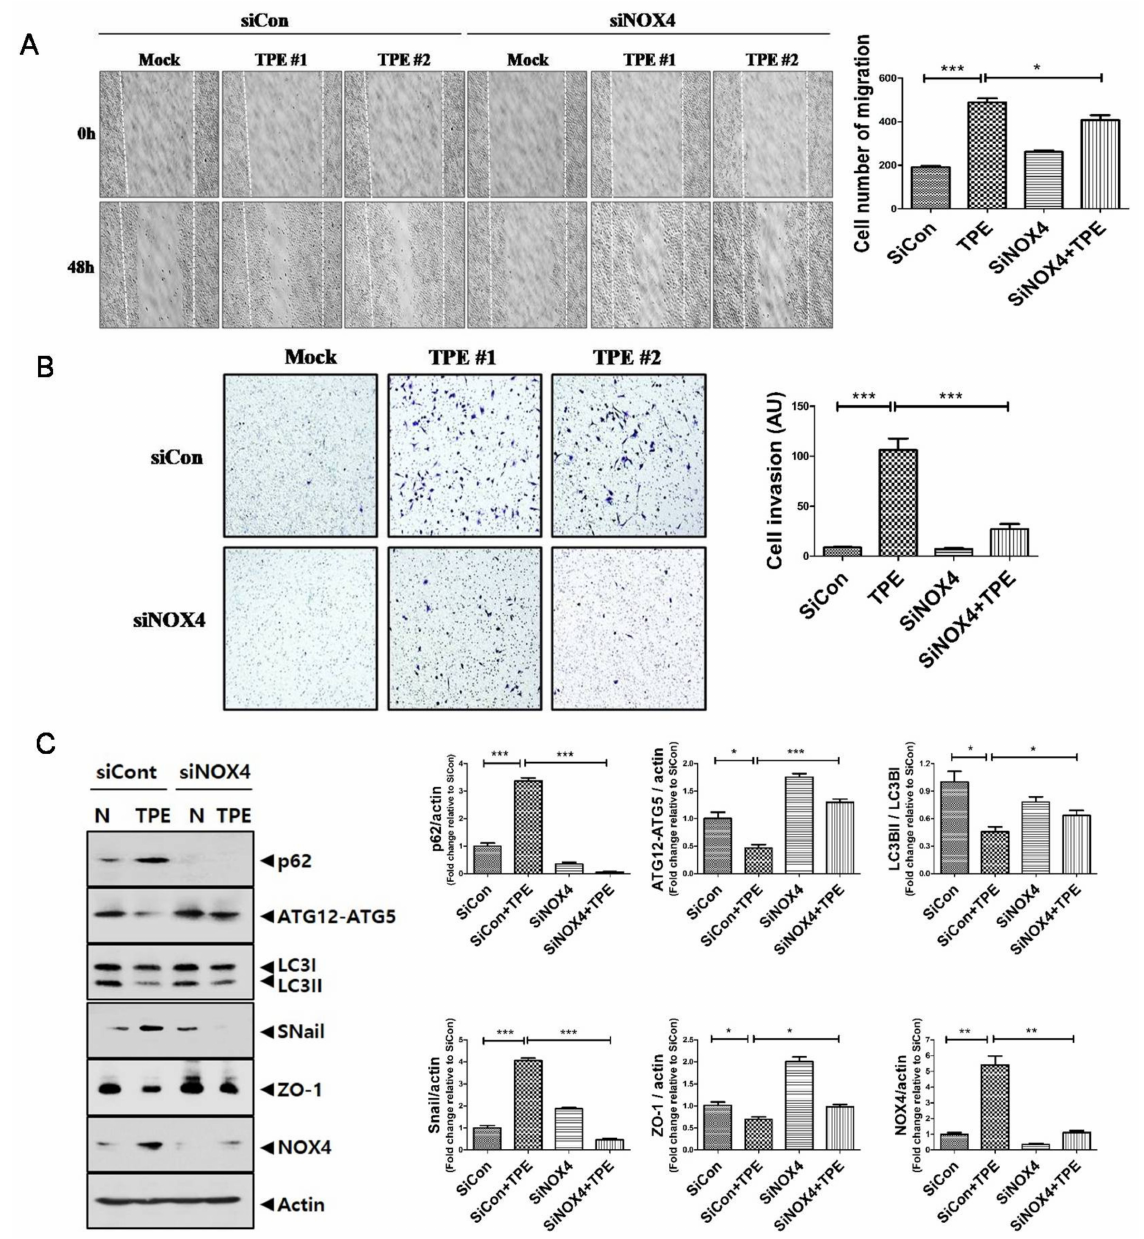
Figure 5. Tuberculous effusion enhances migration and invasion of lung cancer cell: Scratch-wound healing assay ( A ) and Transwell assay ( B ) showed thatNOX4 downregulation significantly prevented the migration and invasion of lung adeno- carcinoma cells that were enhanced by TPE. ( C ) Western blotting of autophagy (P62, ATG5-ATG12, LC3II /LC3I) and EMT markers (Snail and ZO-1) in A549 cells with and without TPE. Data indicate the results of three experiments. *** p < 0.001, ** p < 0.01, * p <